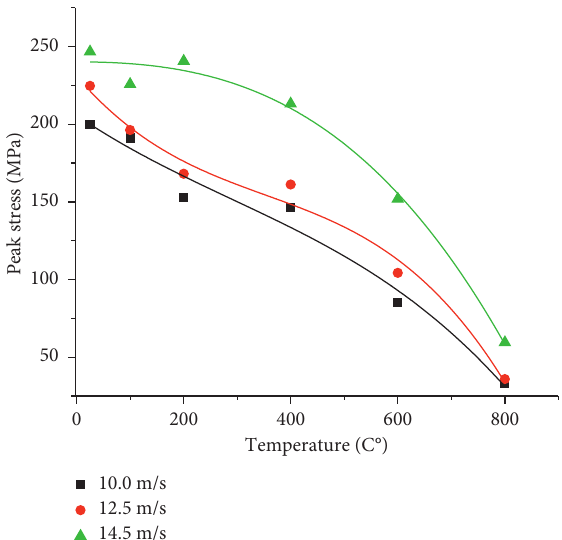
Figure 17: Peak strain-temperature curves of rock under different impact speeds and different temperatures.